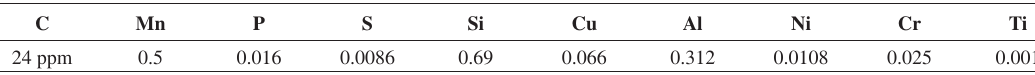
Table 2. Chemical composition of the non oriented steel.